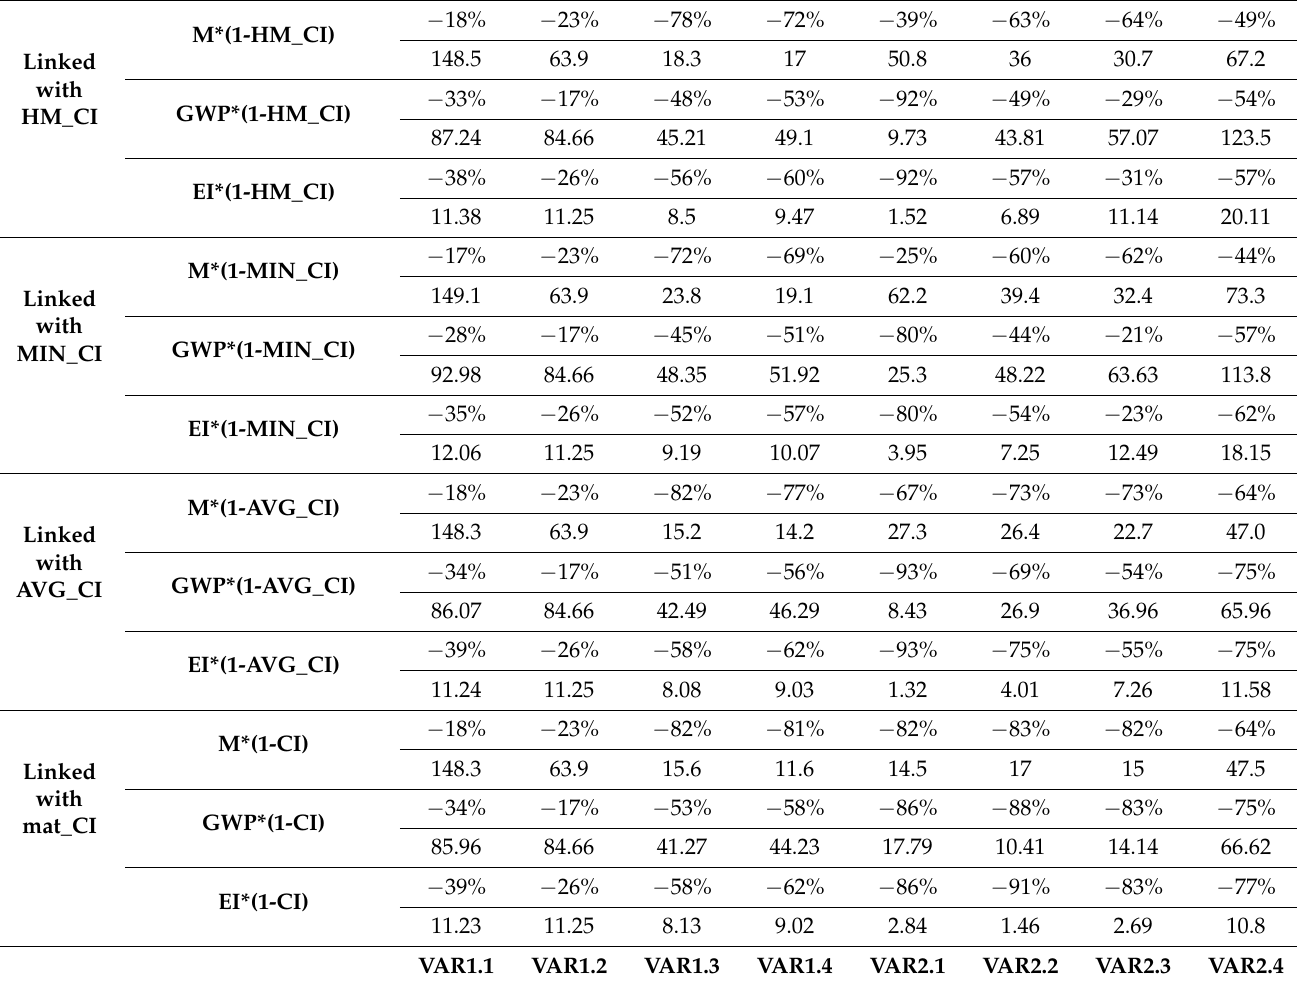
Table 7. Linked EI, GWP and M results of all external wall variants for all four linking options, in absolute values and in relative difference to the